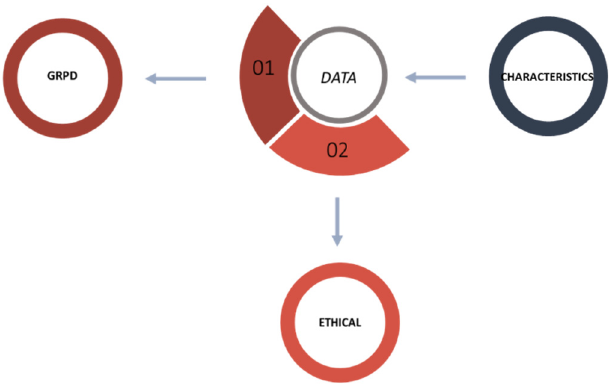
Figure 12. Extended taxonomy of learning objects. Characteristics of data. Source: own elaboration.